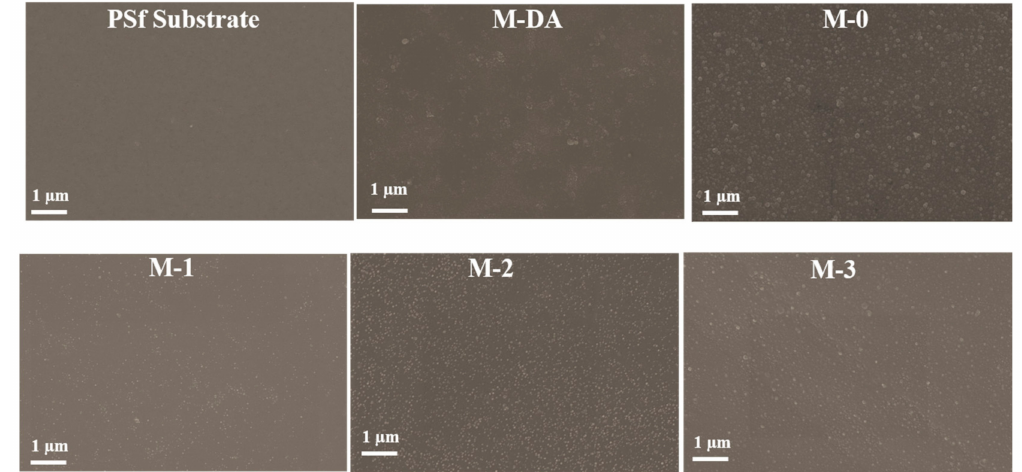
Figure 2. SEM images of PSf substrate, M-DA, M-0, M-1, M-2 and M-3 membrane surface.